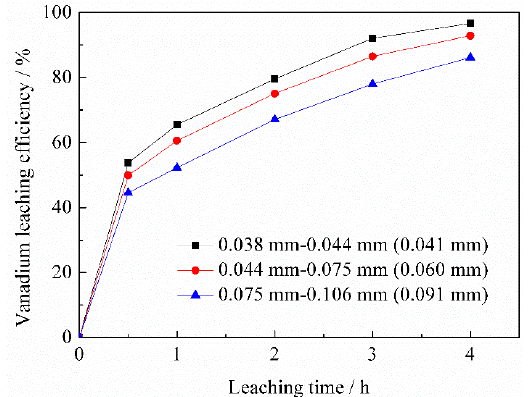
Figure 12. Effect of particle size on vanadium leaching efficiency.